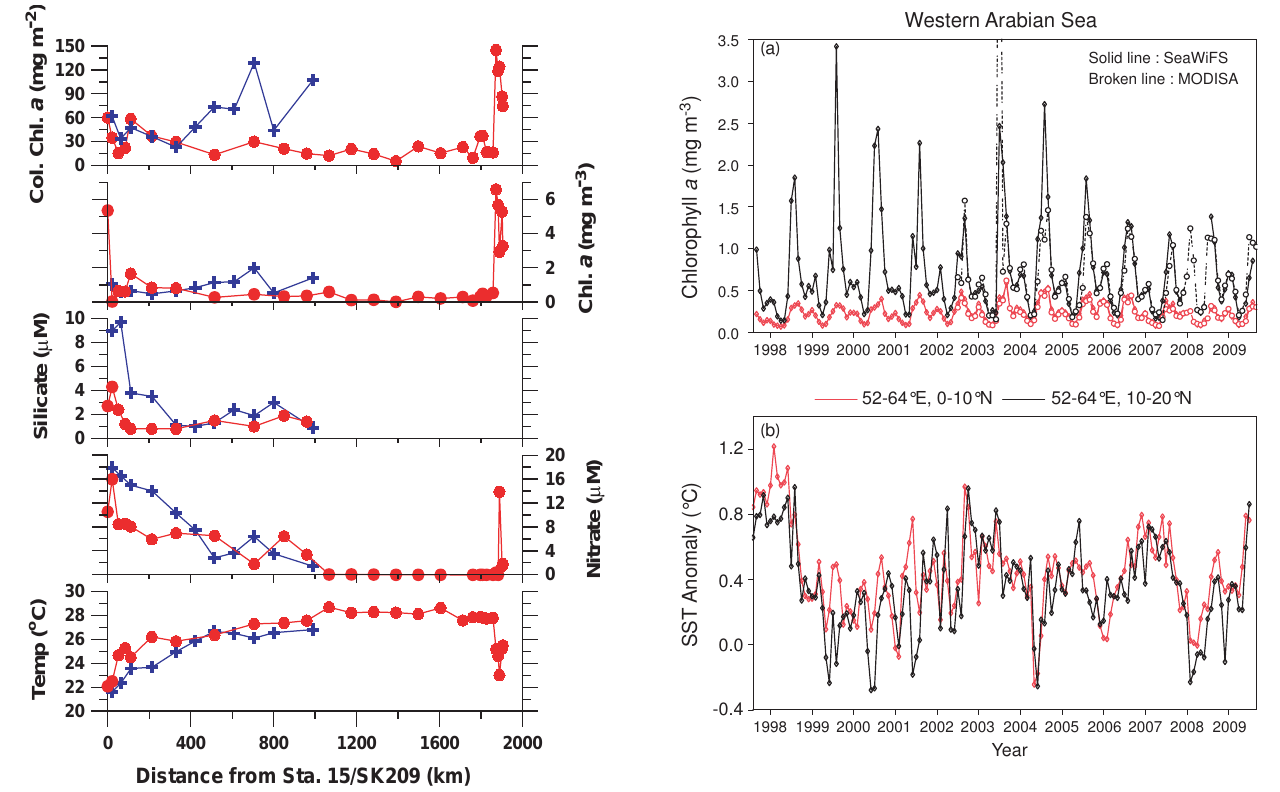
Fig. 2. Variations in water temperature, nitrate (including nitrite), silicate, chlorophyll- a at the sea surface and chlorophyll- a inven- tory (same as in Fig. 1) with distance offshore (measured from SK209 Sta. 15) for the US JGOFS Cruise TN050 (blue symbols) and “Sagar Kanya” Cruises SK208 and 209 (red symbols).